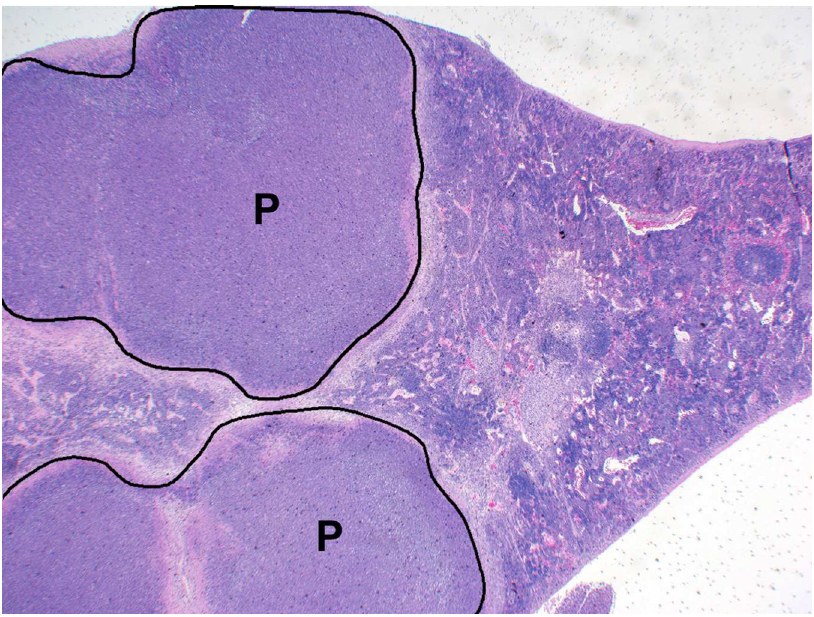
Fig 11. Spleen histopathology observed in mice following exposure to aerosolized B . pseudomallei K96243. BALB/c mouse euthanized on day 15 post-infection and displayedruffled apperanceat that time. Spleen: Multipledistinct pyogranulomas. P = pyogranuloma; H&E